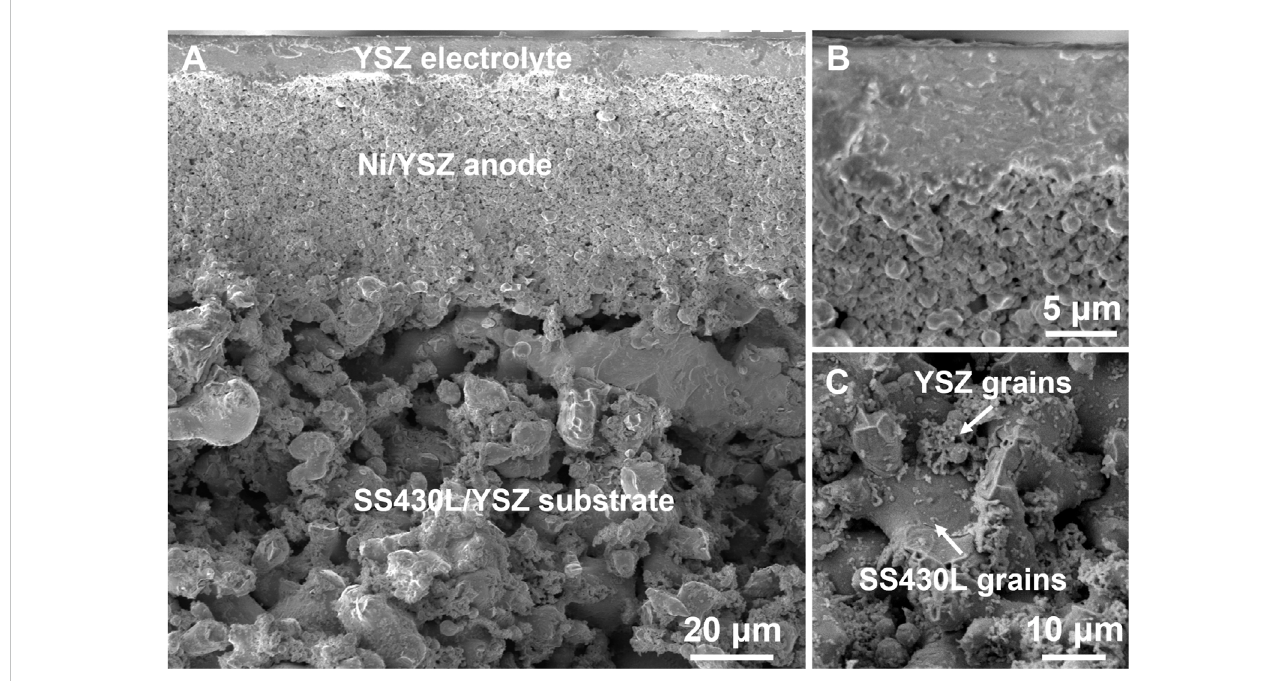
FIGURE 10 SEM images of the following materials: (A) fracture cross section of the MS-SOFC button cell; (B) enlarged image of the electrolyte; and (C) enlarged image of the SS430L/YSZ substrate.